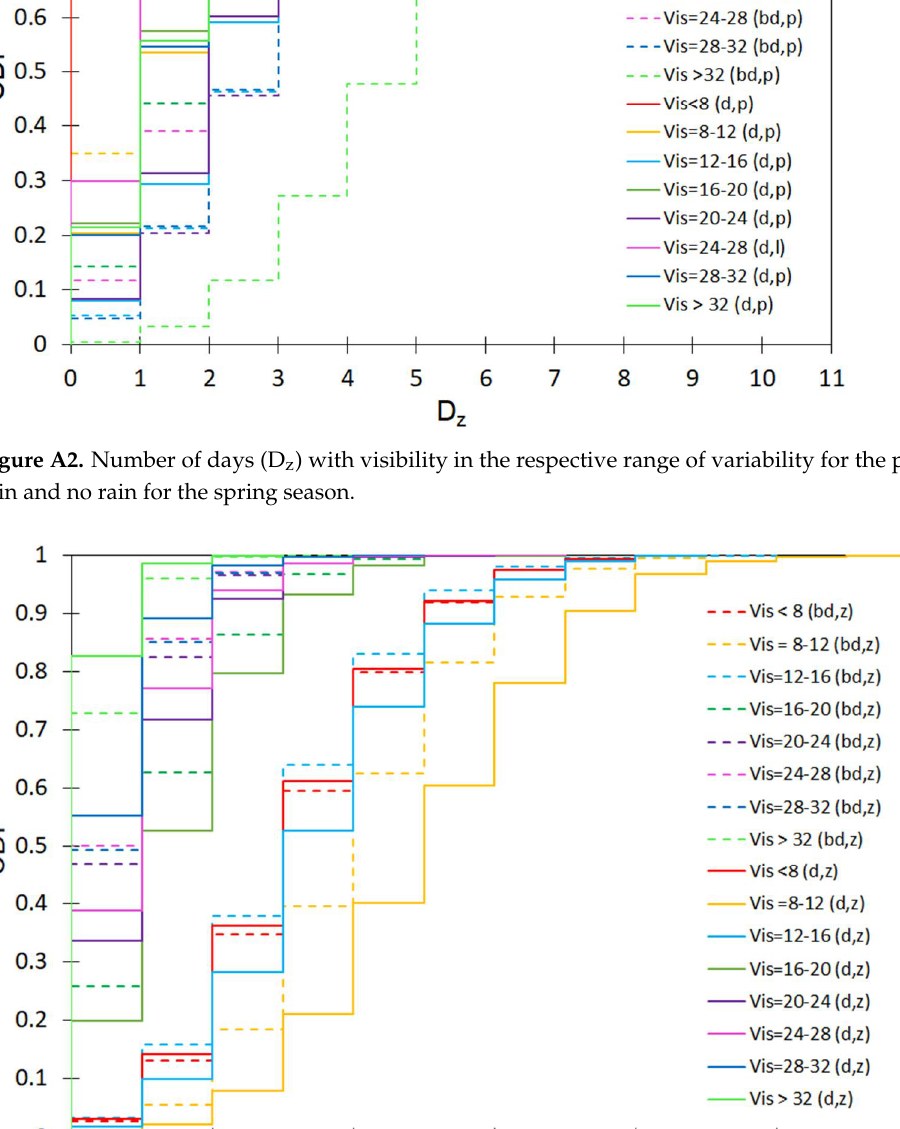
Figure A3. Number of days (D z ) with visibility in the respective range of variability for the period precipitation and rainless period for the winter season.